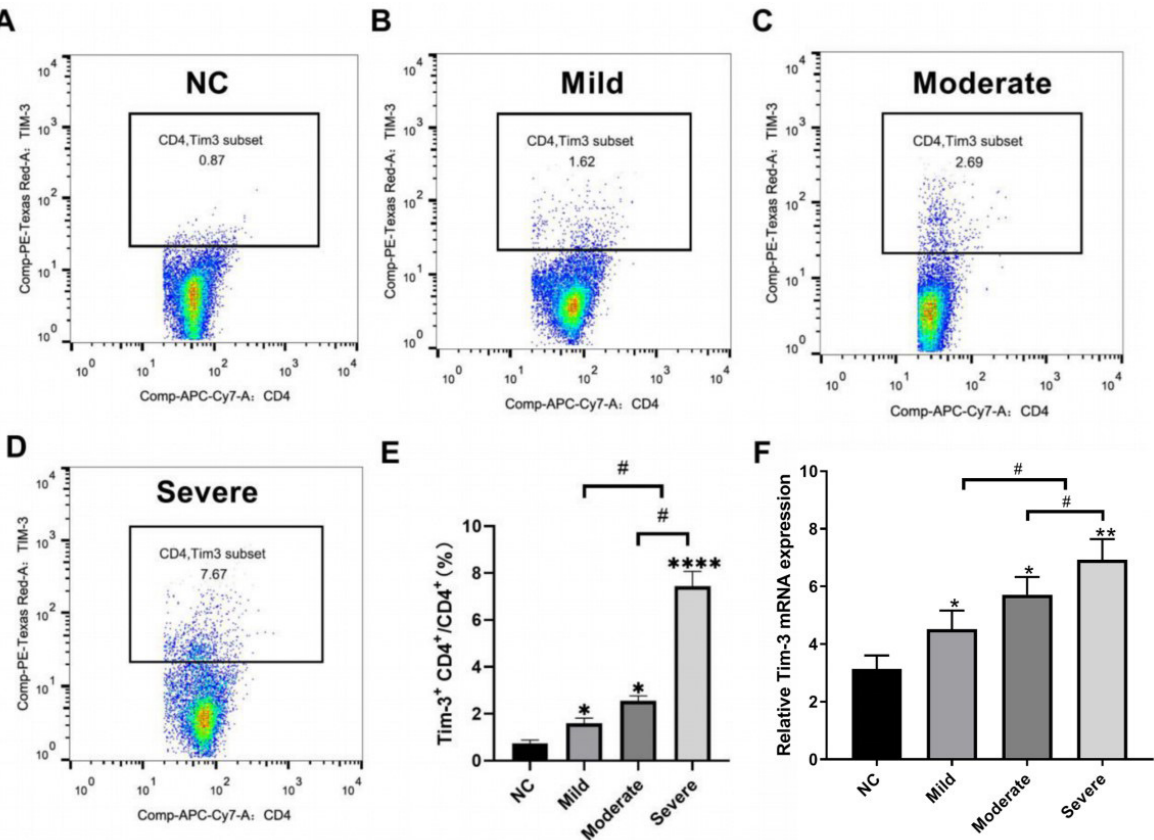
Fig. 1 - Upregulation of the expression of Tim-3 in CD4+ T cells in peripheral blood of patients with CHD. A-D: Flow cytometry was used to